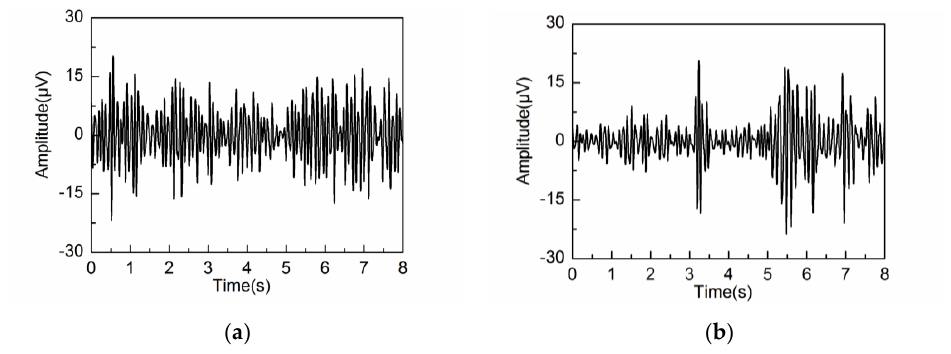
Figure 13. Extracted alpha rhythm by wavelet decomposition (WDec) under: ( a ) eyes-closed condition; ( b ) eyes-open condition.